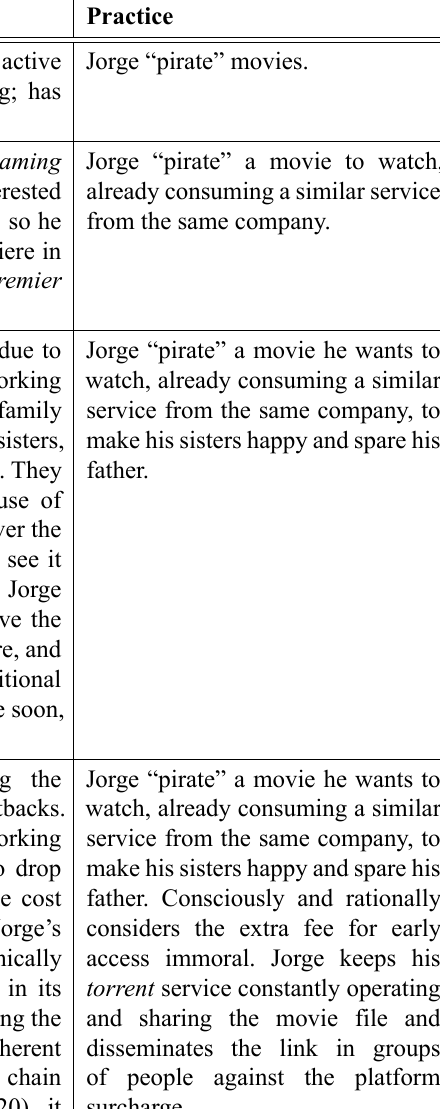
Table 1. A clipping of Jorge’s ethical and moral itineraries in